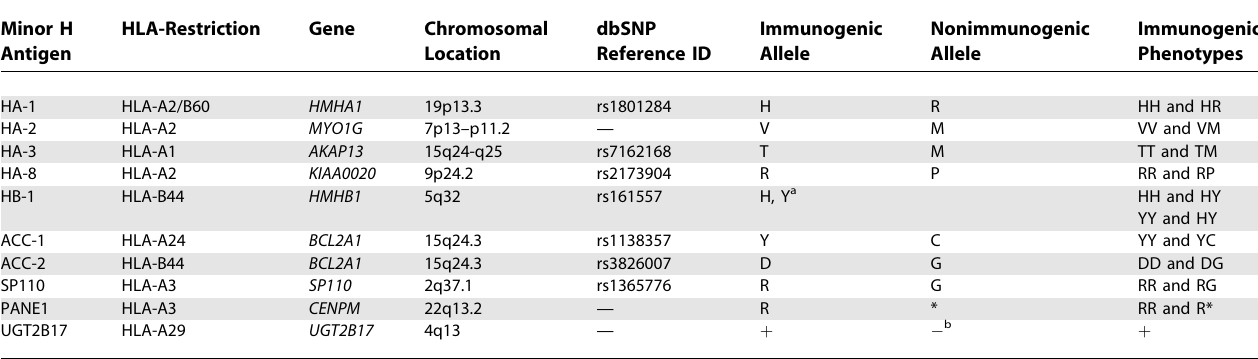
Table 1. Overview of the Characteristics of Ten Minor H Antigens Investigated in this